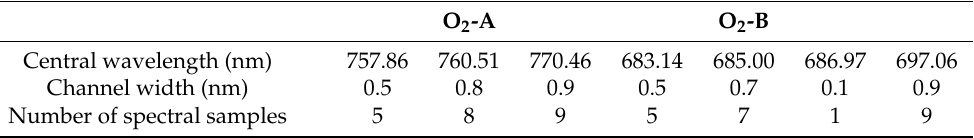
Table A2. Positions and width of the TriFLEX channels in the O 2 -A and O 2 -B bands. O 2